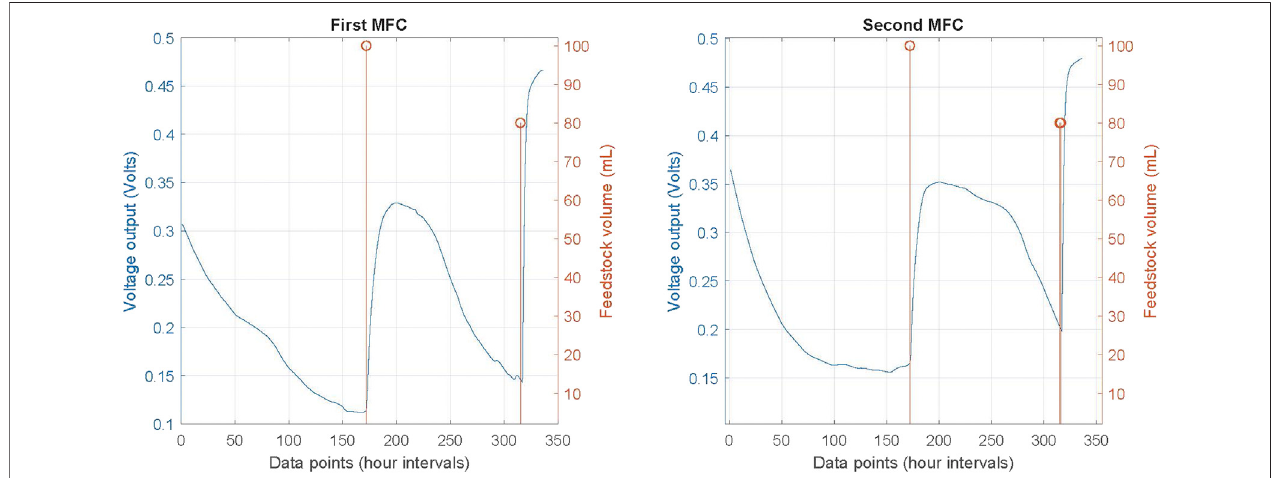
FIGURE 3 | Dataset of voltage output and feedstock added of both